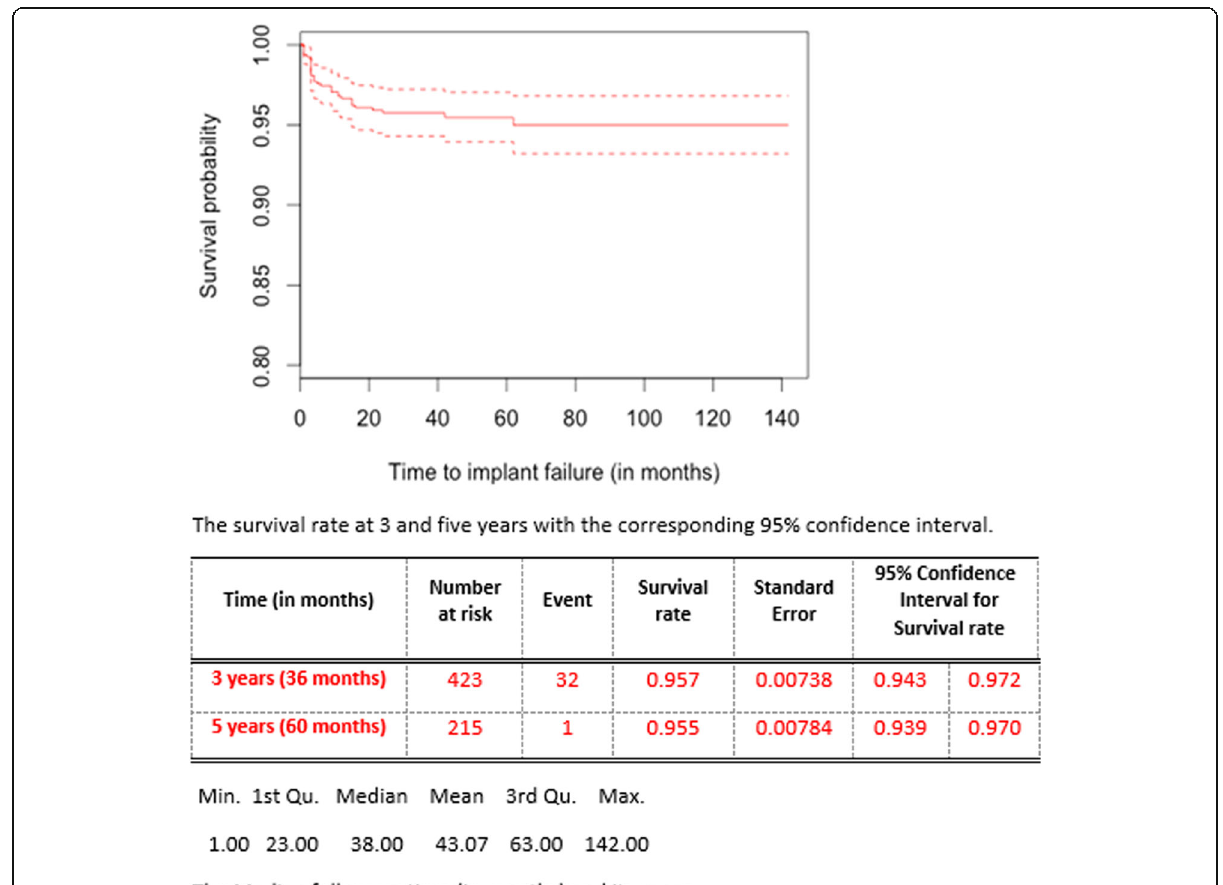
Fig. 2 A Kaplan-Meier survival curve for overall implant failure in this patient cohort. Implant survival rate at 3- and 5-year rates with corresponding CIs are shown. Median follow-up time and its range are also shown. CI confidence interval, Min. minimum, 1st Qu. first quartile, 3rd Qu. third quartile, Max.